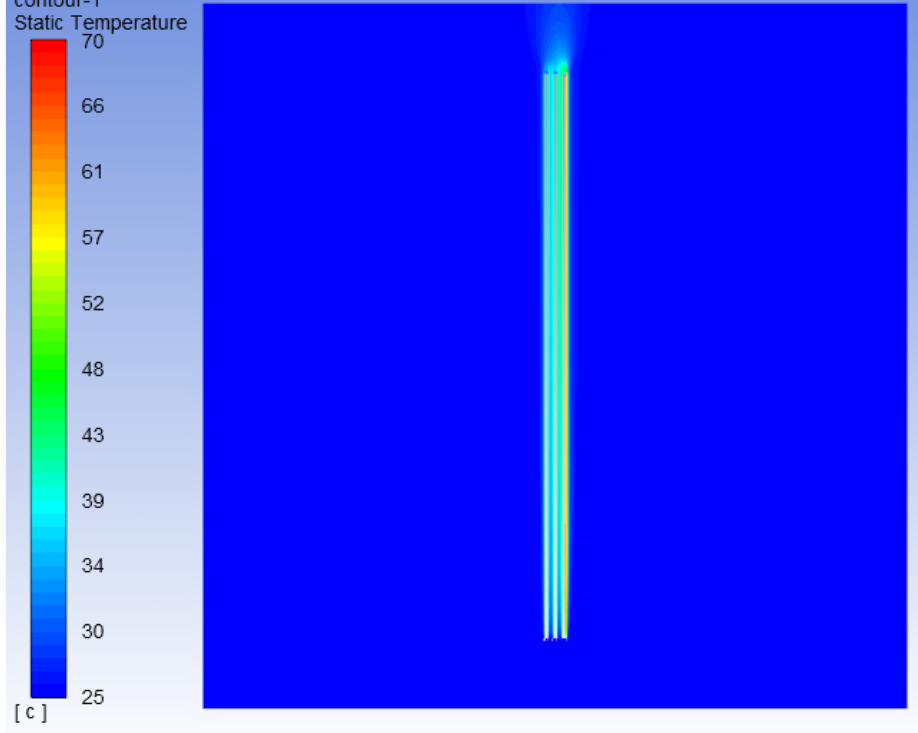
Figure 5. Temperature distribution around power cables (max permissible load: I ZL1 = I ZL2 = I ZL3 = 96 A) taking into account solar radiation.